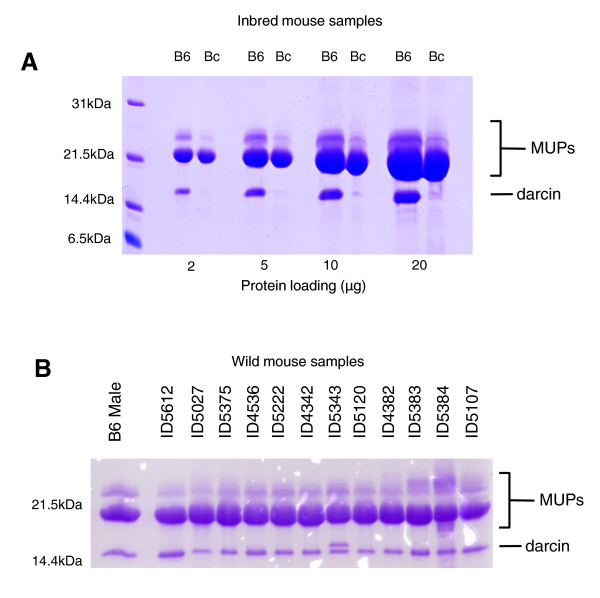
Expression of darcin in C57BL/6, BALB/c and wild male mice. Panel A: Urine from male adult mice of C57BL/6 (B6) or BALB/c (Bc) strains was resolved on SDS-PAGE at different loadings, from normal (2 μg of protein) to heavily overloaded (20 μg of protein) lanes. The high mobility band corresponding to darcin was evident at all loadings in C57BL/6 mice, but was barely evident at 10 μg and 20 μg loadings from BALB/c mice. Densitometric analysis of this gel indicated that darcin constituted approximately 15% of the total major urinary protein (MUP) in C57BL/6 mice, but less than 0.5% of total MUP in BALB/c mice. Panel B: Protein (5 μg) from a number of adult, male, wild-derived mice was analysed by SDS-PAGE. The darcin band, confirmed by mass spectrometry to be darcin, was evident in every animal, at levels similar to that seen in C57BL/6 mice. We do not have an explanation for the doublet in animal ID5343, but it is possible that this mouse is heterozygous for two darcin genes - the upper band has tryptic peptides that match to the darcin sequence [32].